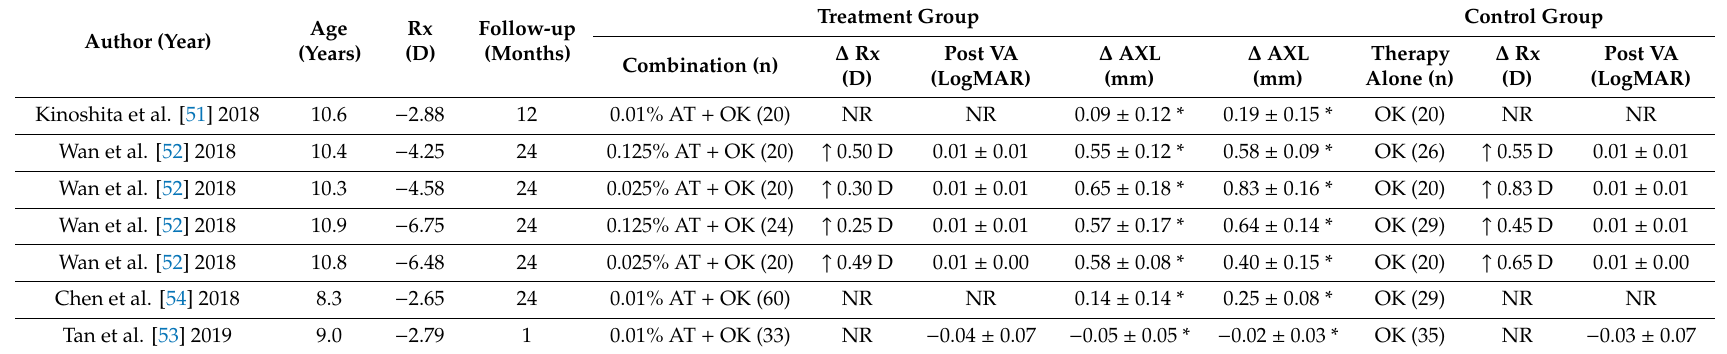
Table 3. Study characteristics and results summary of the four articles included in the low-dose and orthokeratology